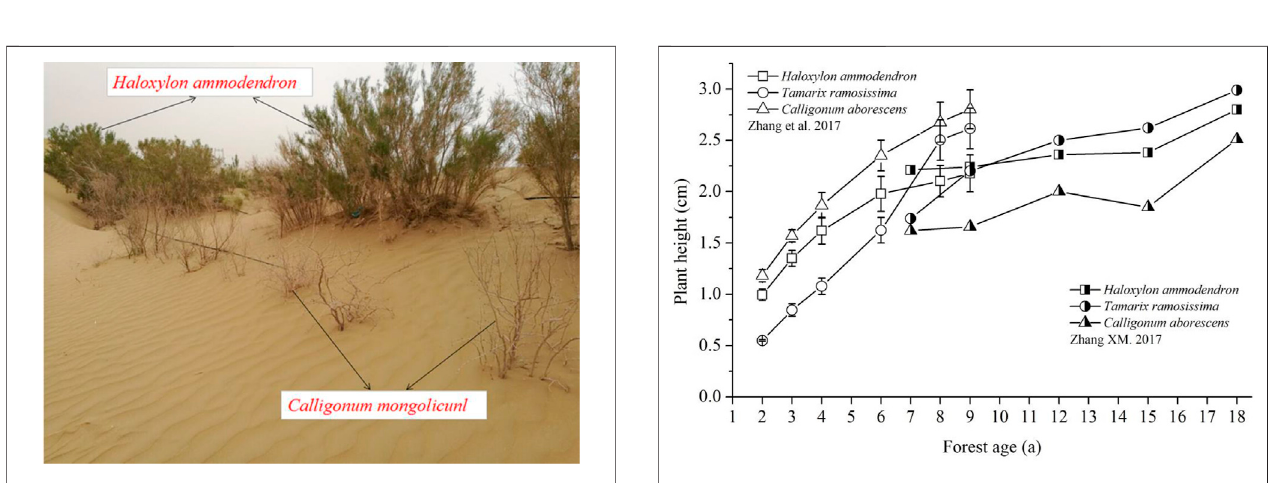
Frontiers in Environmental Science |